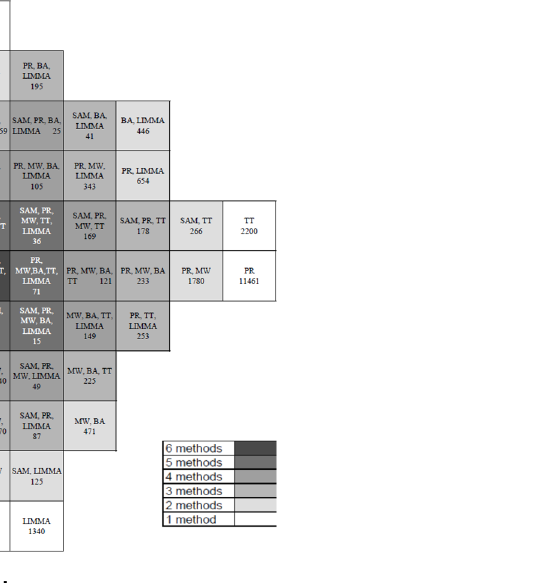
Fig 3. Venn diagram for